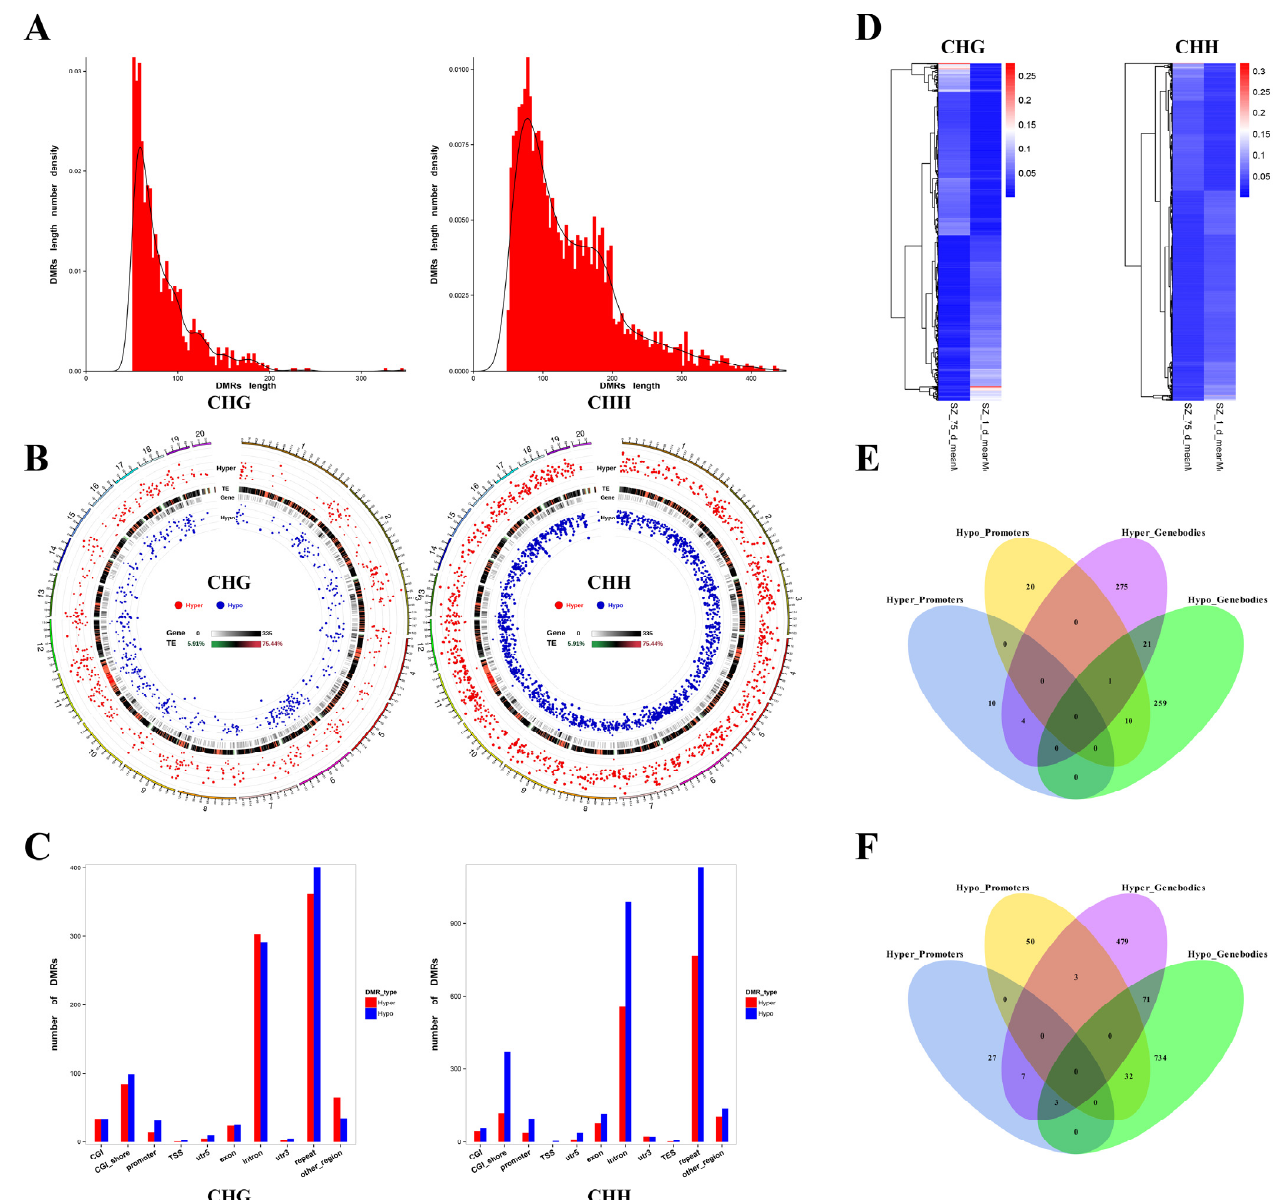
Figure 1. Characteristics of DMRs and DMGs. ( A ) The frequency distribution of two types of DMR count, by length. ( B ) Circos plots of the distribution and significance of two types of DMRs. The outer ring represents the chromosome of the reference genome, and the chromosome information corresponding to the number is listed in Supplementary Table S7. Circos plots were generated according to the length of the chromosome, from long to short: hyper—the distribution of the hypermethylated DMRs, in which the differential methylation level is positively correlated with the distance from the center of the circle; TE—the proportion of repetitive sequences, which turn from green to red, indicates the proportion from low to high; gene—the density of genes in each bin, in which turning from white to black indicates the density becoming larger; and hypo—the distribution of hypomethylated DMRs, in which the differential methylation level is negatively correlated with